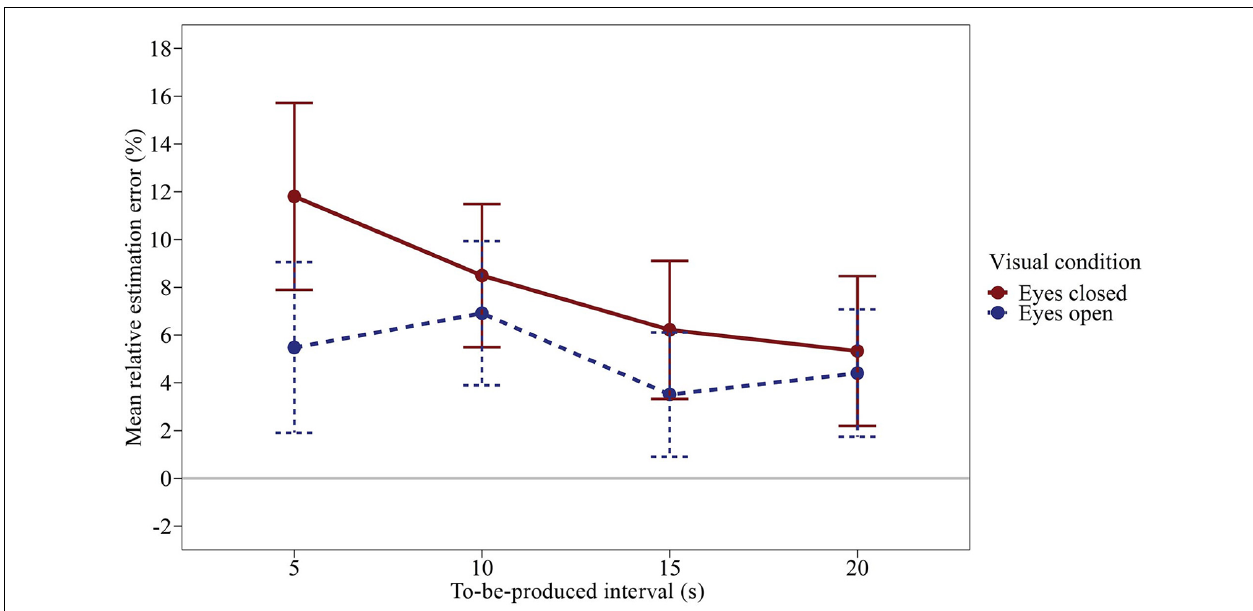
FIGURE 3 | Mean relative estimation error of to-be-produced intervals by visual condition of Experiment 2. Error bars represent ± 1 standard error of the mean (SEM). Values above 0 indicate relative overproduction of the interval.